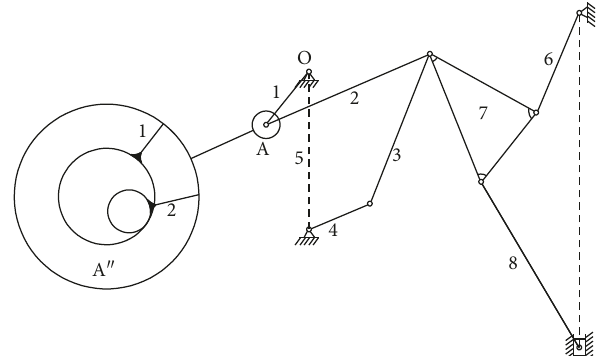
Figure 1: Structure diagram of a planar 2-DOF nine-bar mech- anism with a revolute